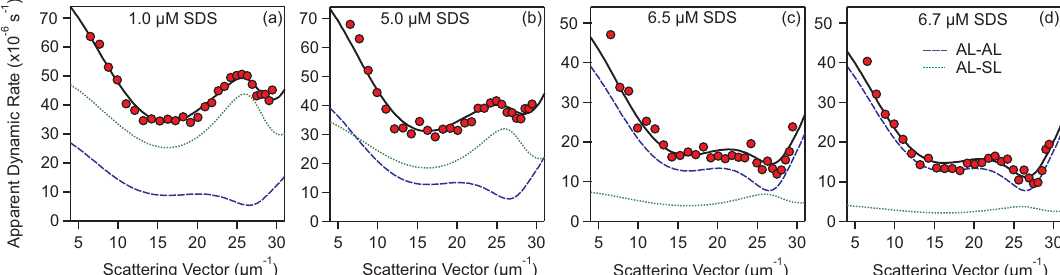
Figure 2. Apparent dynamic rates for the mixture of AL and SL particles as a function of the magnitude of the scattering vector Q at ( a ) 1.8 µ M, ( b ) 5.0 µ M, ( c ) 6.5 µ M, and ( d ) 6.7 µ M SDS. The symbols are experimentally determined apparent rates, while full line represents the fit to Equation (4). The dotted and dashed lines represent the contribution of AL-AL and AL-SL aggregates. The particle concentrations used are 0.50 mg/L (3.4 · 10 − 14 m − 3 ) and 0.23 mg/L (3.3 · 10 − 14 m − 3 ) for AL and SL,